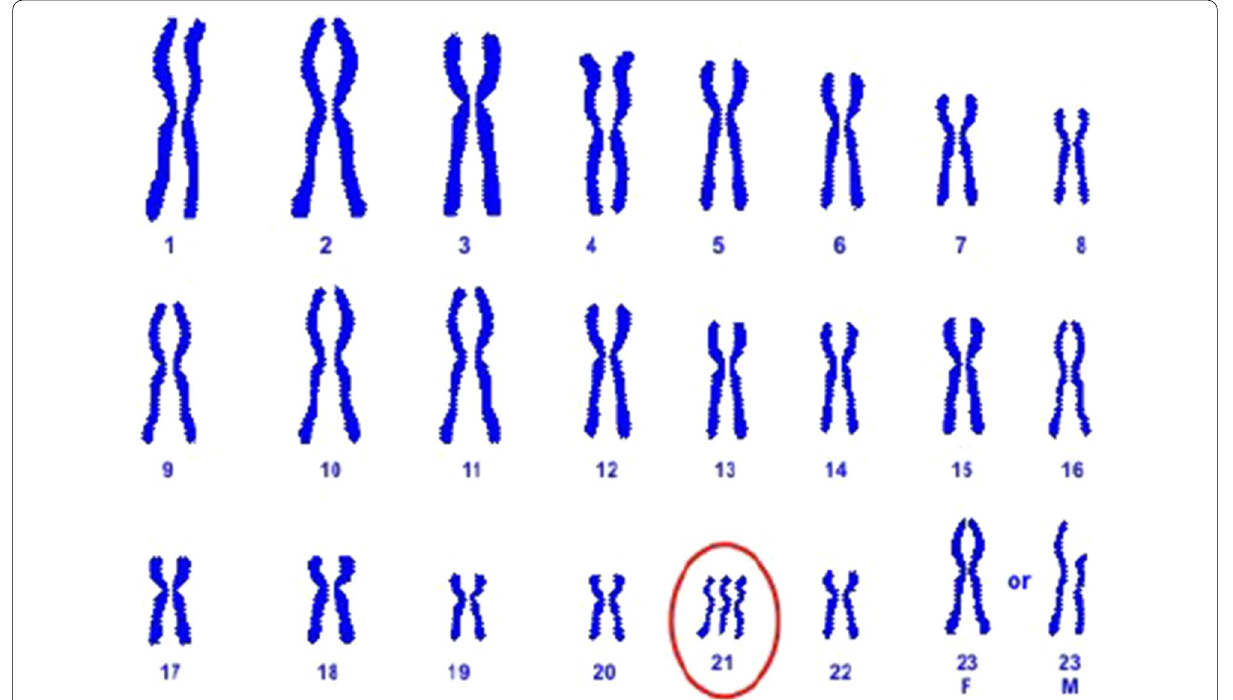
Fig. 6 A karyogram of Down